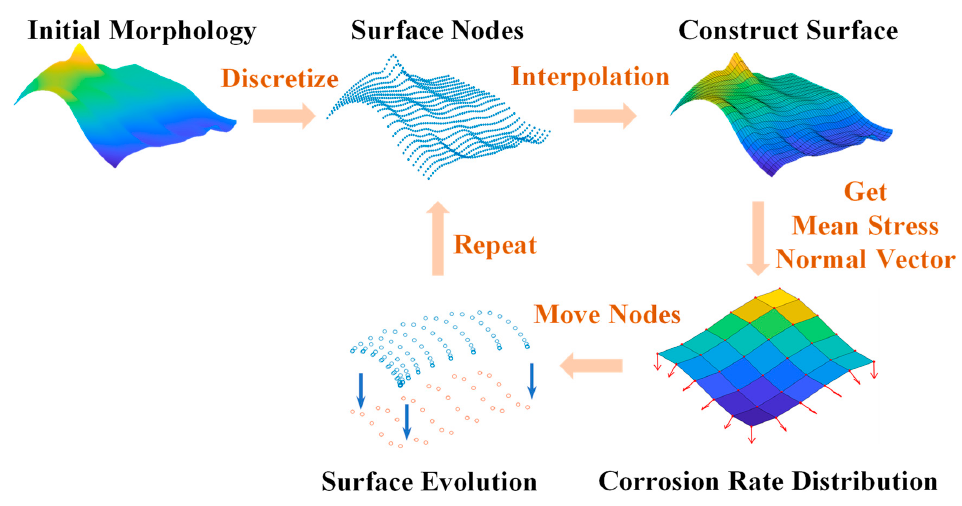
Figure 3. Procedure of tracking the surface movement under stress corrosion. In the finite element method, the surface moving is represented by position changes in the surface nodes. In order to avoid that corrosion depth of the surface from being overlarge due to the stress concentration, which will eventually result in a numerical problem, the time interval ∆ t is limited by a maximum corrosion depth in each computational step